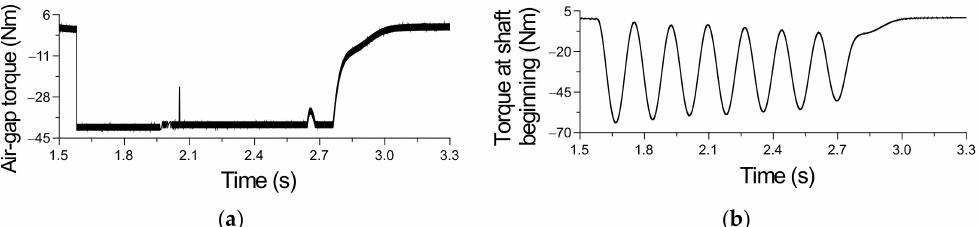
Figure 9. Waveforms of the air-gap torque of an induction motor ( a ) and the torque at the point of connection of the induction motor with the transmission shaft ( b ) during the motor reversal in the drive system shown in Figure